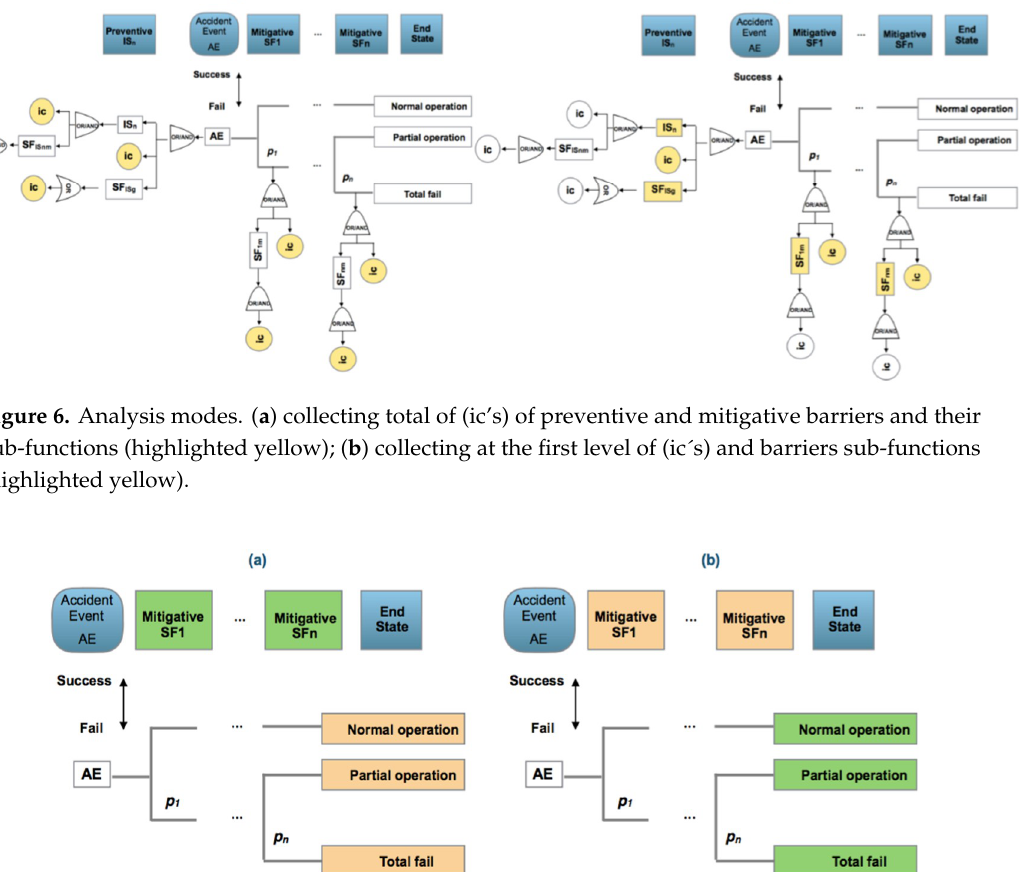
Figure 8. Potential causes (pot) and attributes defined in the Statistical Risk Control (SRC) methodology. 3.3. General Application for Occupational Accidents In accordance with the SRC methodology, a bow-tie is defined in each particular scenario. In the case of occupational accidents before being able to work with different risk scenarios, it is necessary to analyze what human behavior is at work and what are the factors that affect it. Three views and organizations that cover the most critical have been considered. The first group compiled is general, [17,122,123]. The second group includes the factors considered critical in the 6th European Survey of Working Conditions [124], and the third group includes the emerging psychosocial risks related to occupational safety and health [125]. The aggregation and coincidence of the three groups is presented in Figure 9.